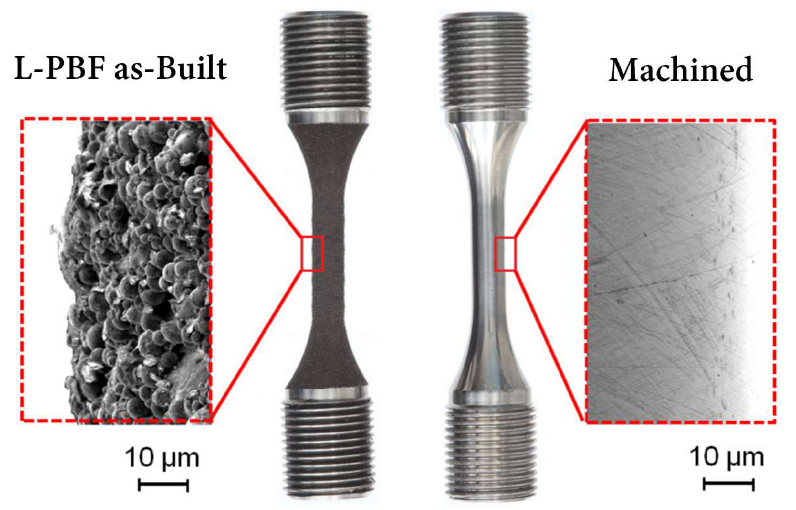
Figure 2. Example PBF-LB surface finish before and after machining process for a Ti-6Al-4V part [90] (Reprinted with permission from [90]. Copyright 2015, Elsevier).